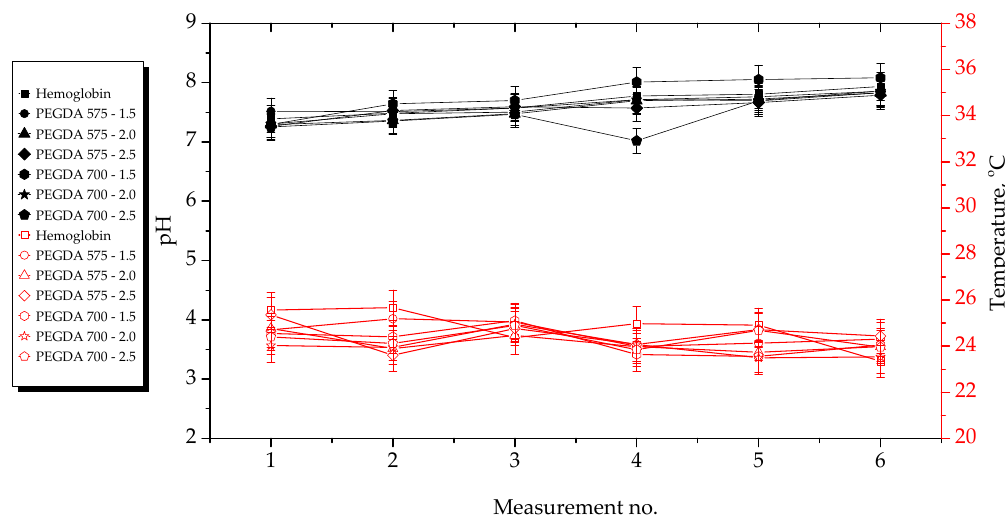
Measurement no. Figure 6. Results of hydrogel incubation in Figure 6. Results of hydrogel incubation in hemoglobin. According to the results presented above, the hydrogels showed the highest stability in SBF and 2% hemoglobin solution because the pH values of the liquids only changed to a limited extent during the incubation period. Such insignificant changes may be ex- plained by the dense crosslinking of the hydrogel networks that likely occurred during their incubation both in SBF, which contains numerous divalent ions, and in protein-con- taining hemoglobin solution. On the other hand, the most considerable changes in pH values were observed in the case of distilled water, which contains neither ions nor proteins that could interact with the hydrogel network, thus forming additional crosslinks and limiting the release of the modifying agents ( Aloe vera juice and vitamin C). Both these modifiers are acidic; thus, when they were released from the hydrogel matrix as a result of loosening of the polymer chains, the pH value of the distilled water decreased from approximately 7.5 to approxi- mately 3.0. In the case of Ringer solution, the changes in its pH demonstrated the buffering properties of the hydrogels. This incubation medium contains fewer divalent ions (such as Ca 2+ ) than SBF; thus, the modifiers may have been released. Notably, the pH value of this Ringer solution changed until it was stabilized with at the fourth measurement. Importantly, the lack of significant differences in pH values between the tested sam- ples proved that the incubation medium had a greater impact on the release of the modi- fying agent than the amount or the average molecular weight of the crosslinking agent. Incubation studies were also performed to verify whether the tested hydrogels de- graded in the tested environments. Degradation of such materials could lead to a perma- nent decrease or increase in the pH of the incubation medium as a result of the formation of degradation products. The lack of increase in pH values showed that the analyzed ma- terials did not degrade in incubation environments. FT-IR spectra of the hydrogels before and after incubation were compared to verify this conclusions. The results of spectro- scopic analysis are presented in next subsection. 2.3. Analysis of Hydrogel Structure Using FT-IR Spectroscopy FT-IR spectroscopy results are presented in Figures 7 and 8. The FT-IR spectra of hydrogels before and after incubation in simulated physiological liquids were summa- rized to verify the impact of the study on their structure.